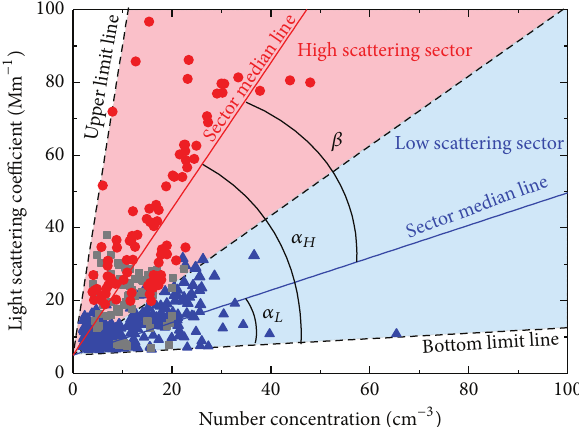
Figure3:Therelationshipbetweenthelightscatteringcoefficient(at 550 nm) and the particle number concentration ( 𝐷 pa > 0.5 𝜇 m) in different air masses arriving from Sahara storm area (red), Atlantic Ocean (blue), and continent